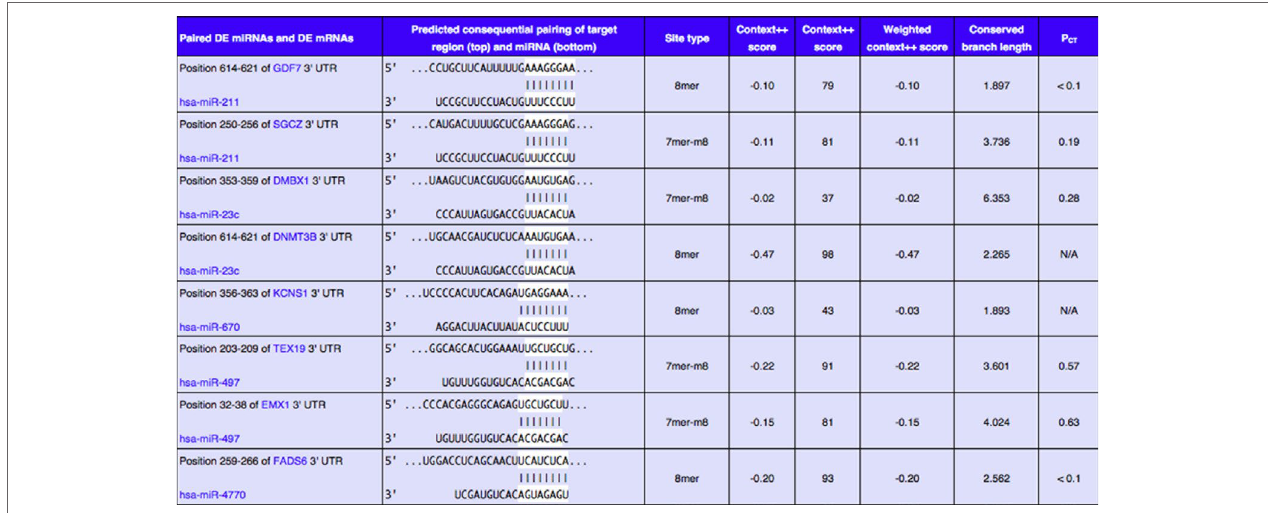
FIGURE 4 | Eight predicted consequential pairings of DE miRNAs and target regions of DE mRNAs associated with survival. These enrolled miRNA–mRNA pairs not only contained conserved binding sites but also had opposite expression levels in EC samples as compared with normal tissues.